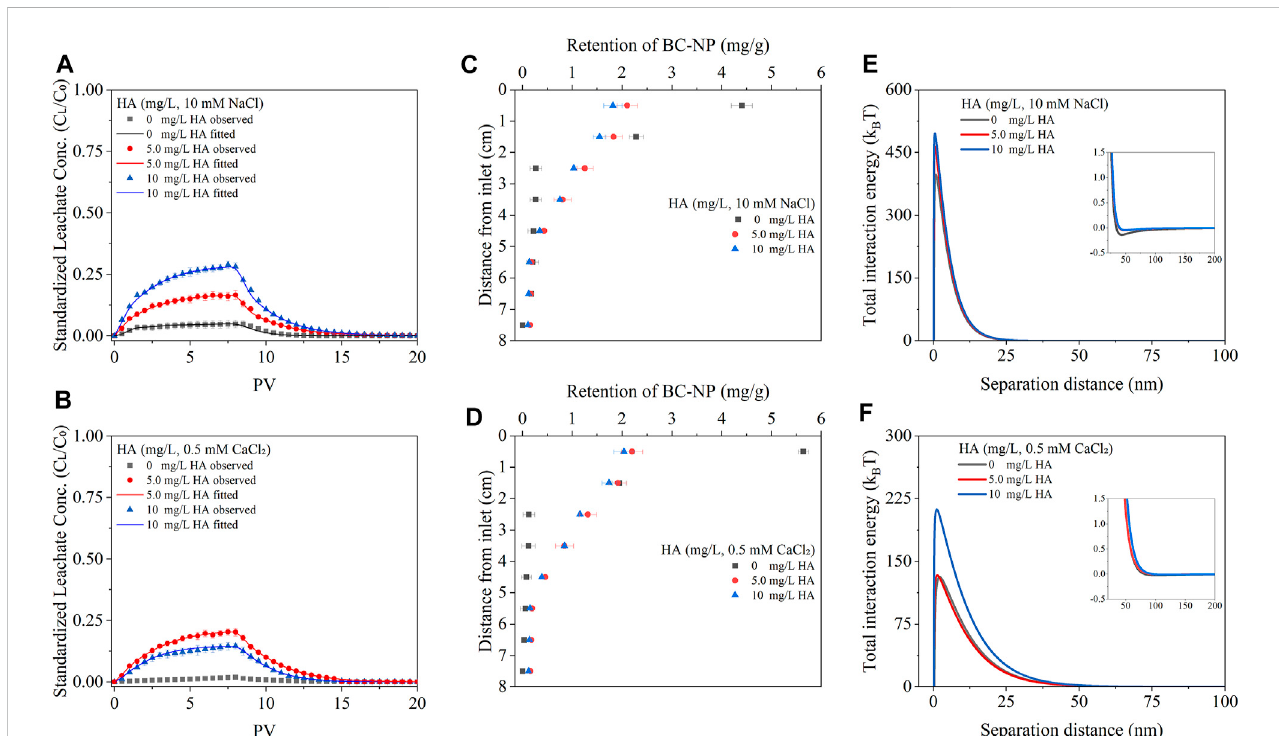
FIGURE 5 Observed(solidsymbols)and fi tted(solid lines)breakthroughcurves (A,B) ,retentioncurvesofbiocharnanoparticles(BC-NP)insoil-packedcolumns (C, D) ), and DLVO interaction energy between BC-NP and soil particles [Insets highlight the secondary minimum; (E,F) ] at varying concentrations of HA (0, 5.0, and 10 mg/L) in the presence of 10 mM NaCl or 0.5 mM CaCl 2 in 10~18 mesh soil-packed column. Error bars represent the standard deviation of means ( n =